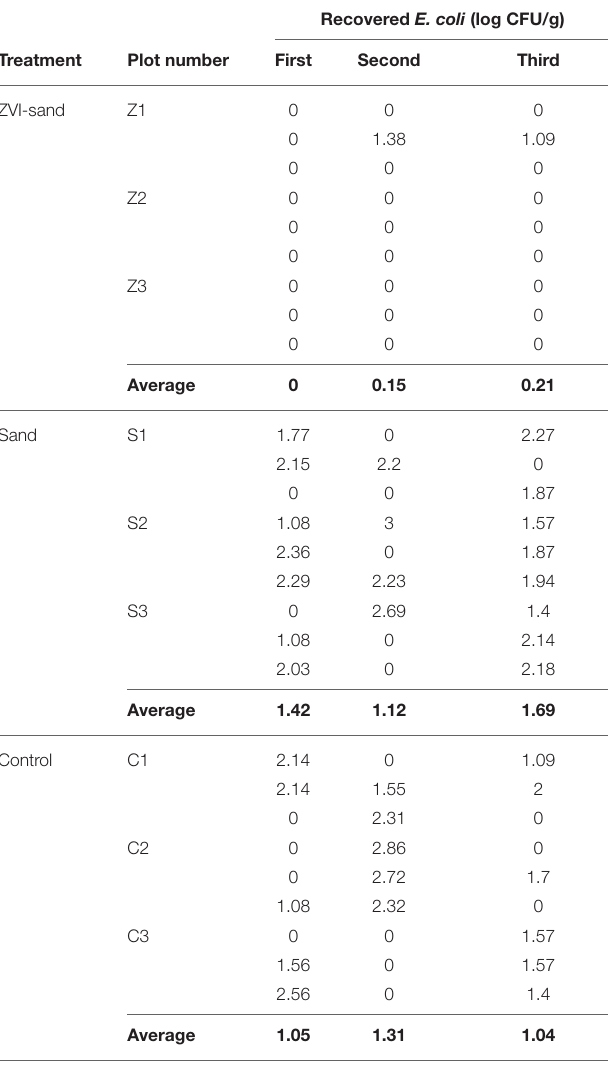
TABLE 7 | E. coli TVS 353 population (log CFU/g) in soil samples after irrigation by ZVI-sand, sand filtration and control (no filtration) water. Recovered E. coli (log